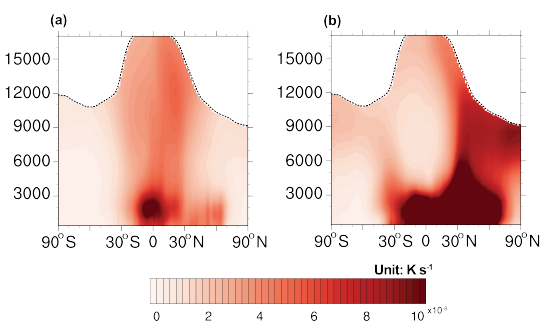
Figure 15. Global zonal mean distributions of the heating rate of (a) BrC and (b) BC for 5 years of present-day simulations. The dashed line denotes the